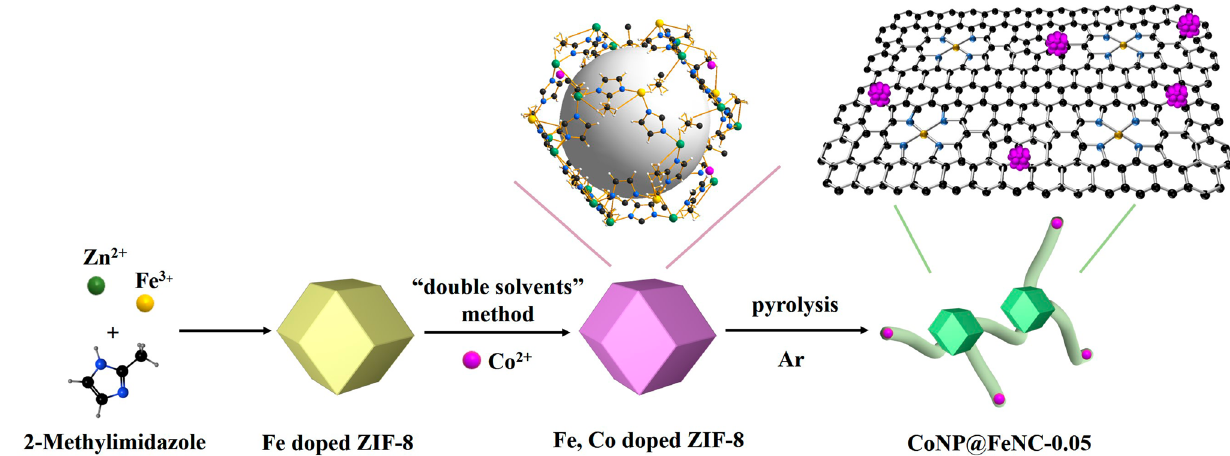
Fig. 1 Schematic illustration for the fabrication of CoNP@FeNC